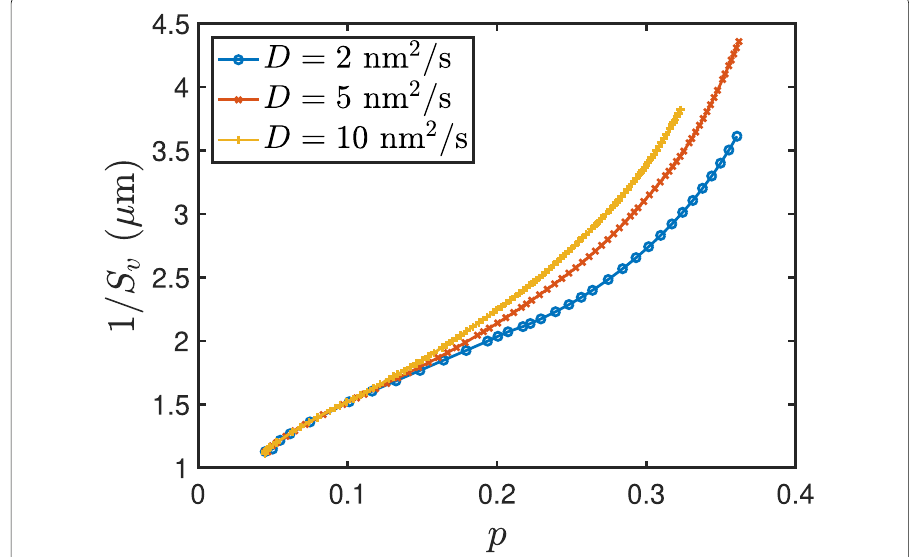
Fig. 5 Characteristic length scale S − 1 v for varying simulated diffusivities (initial conditions of configuration 1). S − 1 v remains an order of magnitude smaller than the simulation domain size L x = 72 μ